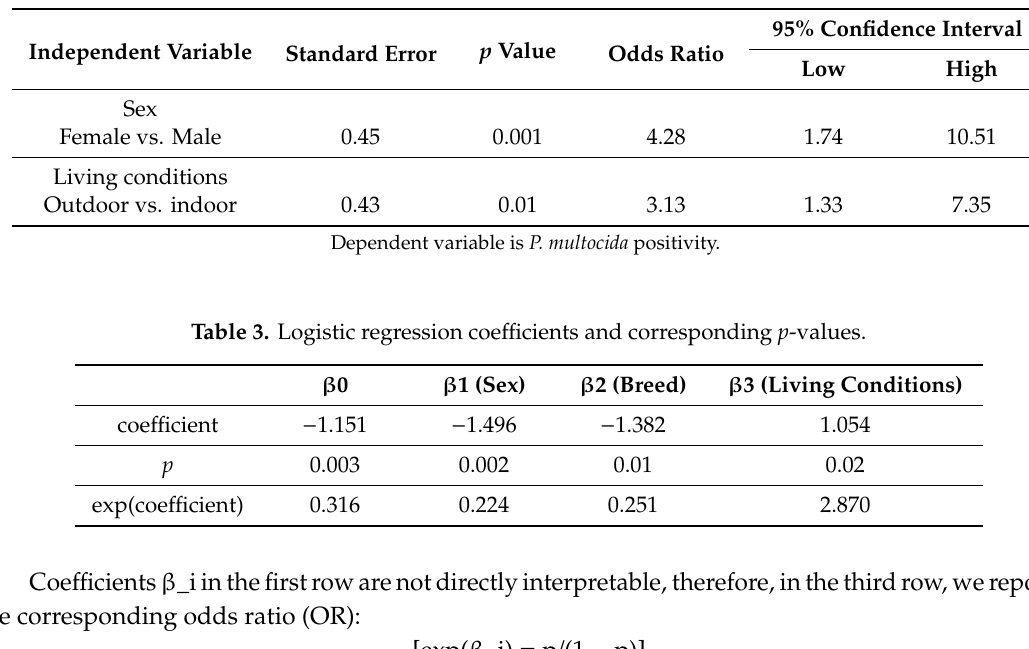
Table 2. Cochran–Mantel–Haenszel test.